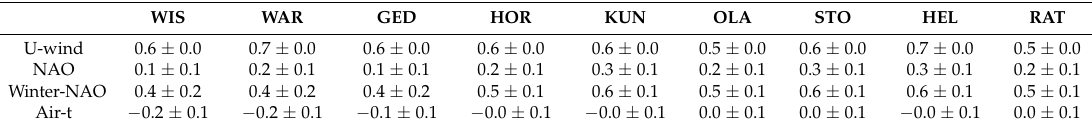
Figure 15. Average of sea level CSEOF first mode PC time series in winter (December–March) at nine tide gauges (Table 2) in 1900–2012. The PC time series of winter-NAO is overlaid. Table 2. Correlations between CSEOF first mode sea level and zonal wind (U-wind), air temperature (Air-t) PC time series, NAO, and winter NAO at WIS (Wismar), WAR (Warnemunde), GED (Gedser), HOR (Hornbaek), KUN (Kungsholmsfort), OLA (Olands Norra Udde), STO(Stockholm), HEL(Helsinki) and RAT (Ratan) over the period 1900–2012. WIS WAR